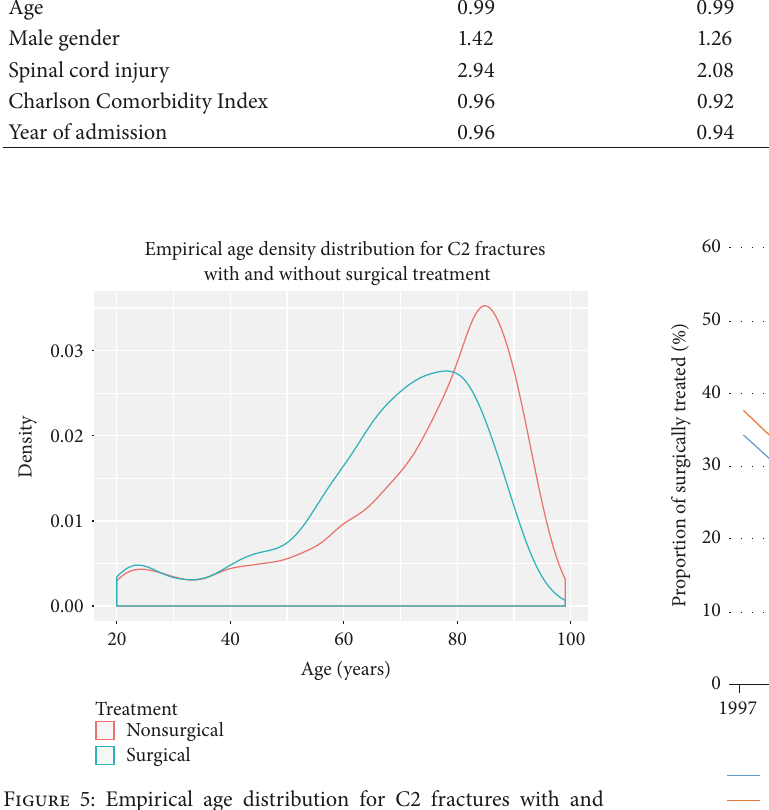
Figure 5: Empirical age distribution for C2 fractures with and without surgical treatment.